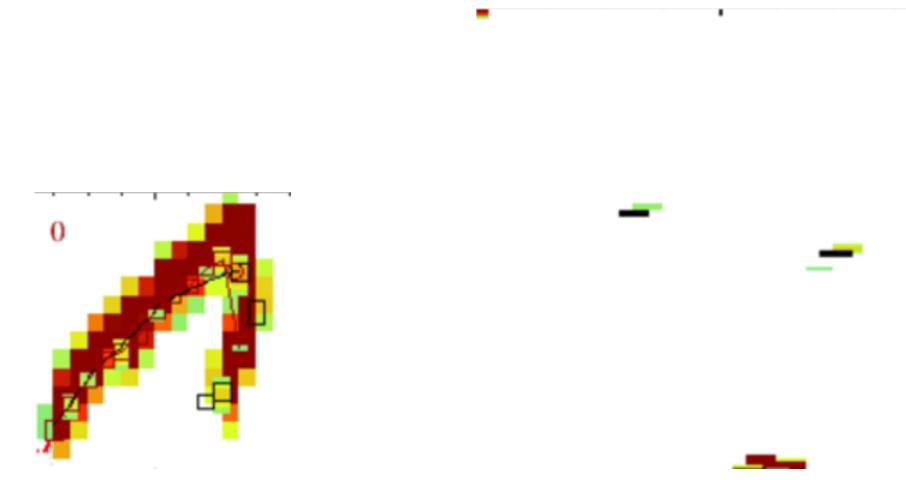
Figure 10. Left) a charged current interaction of a 30 MeV energy electron neutrino in the DUNE Far Detector. Right) a neutral current excitation and de-excitation of an Ar nucleus by a 10 MeV neutrino.